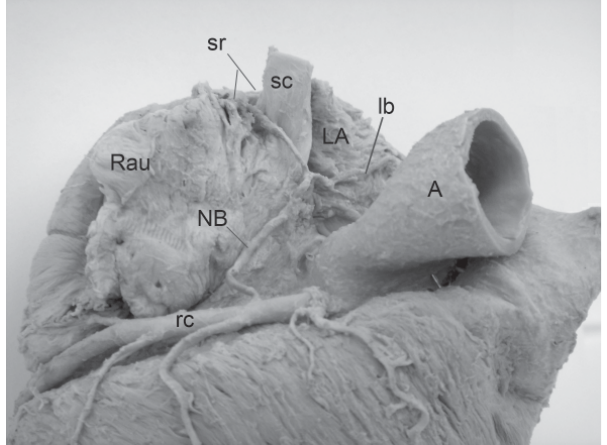
Figure 2 - The sinuatrial nodal branch (NB) is type R1